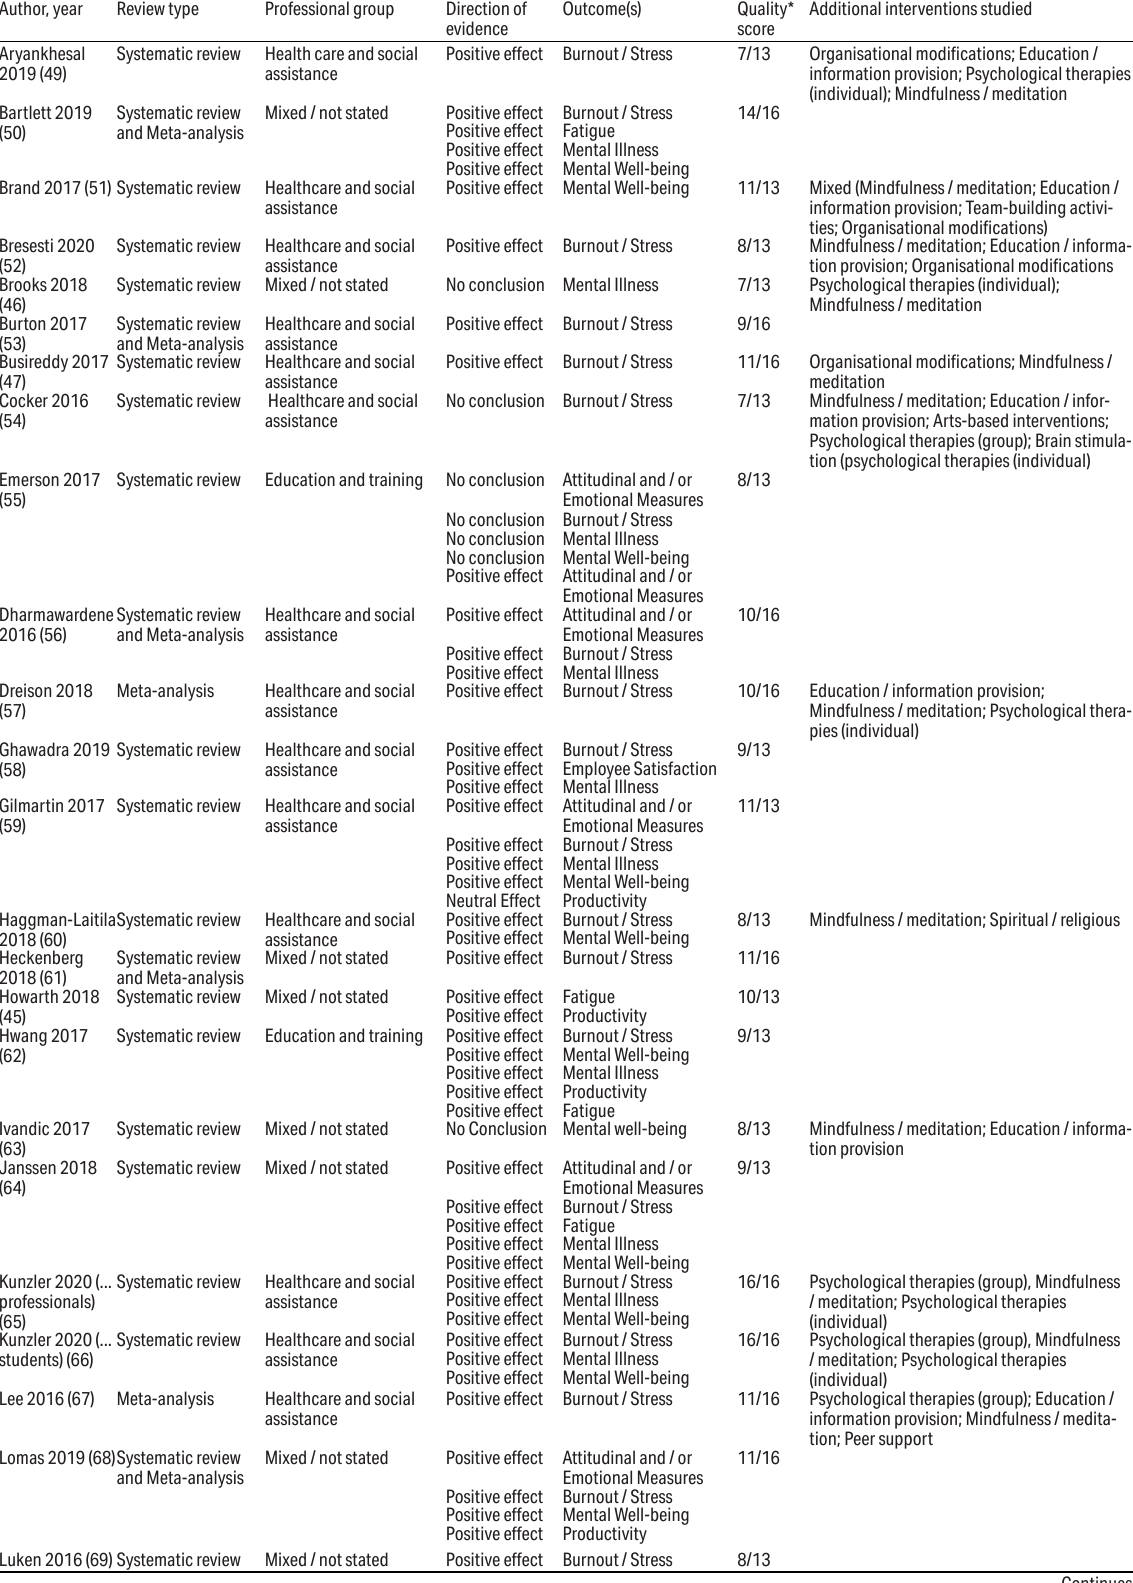
Table 1. High quality reviews of mindfulness and